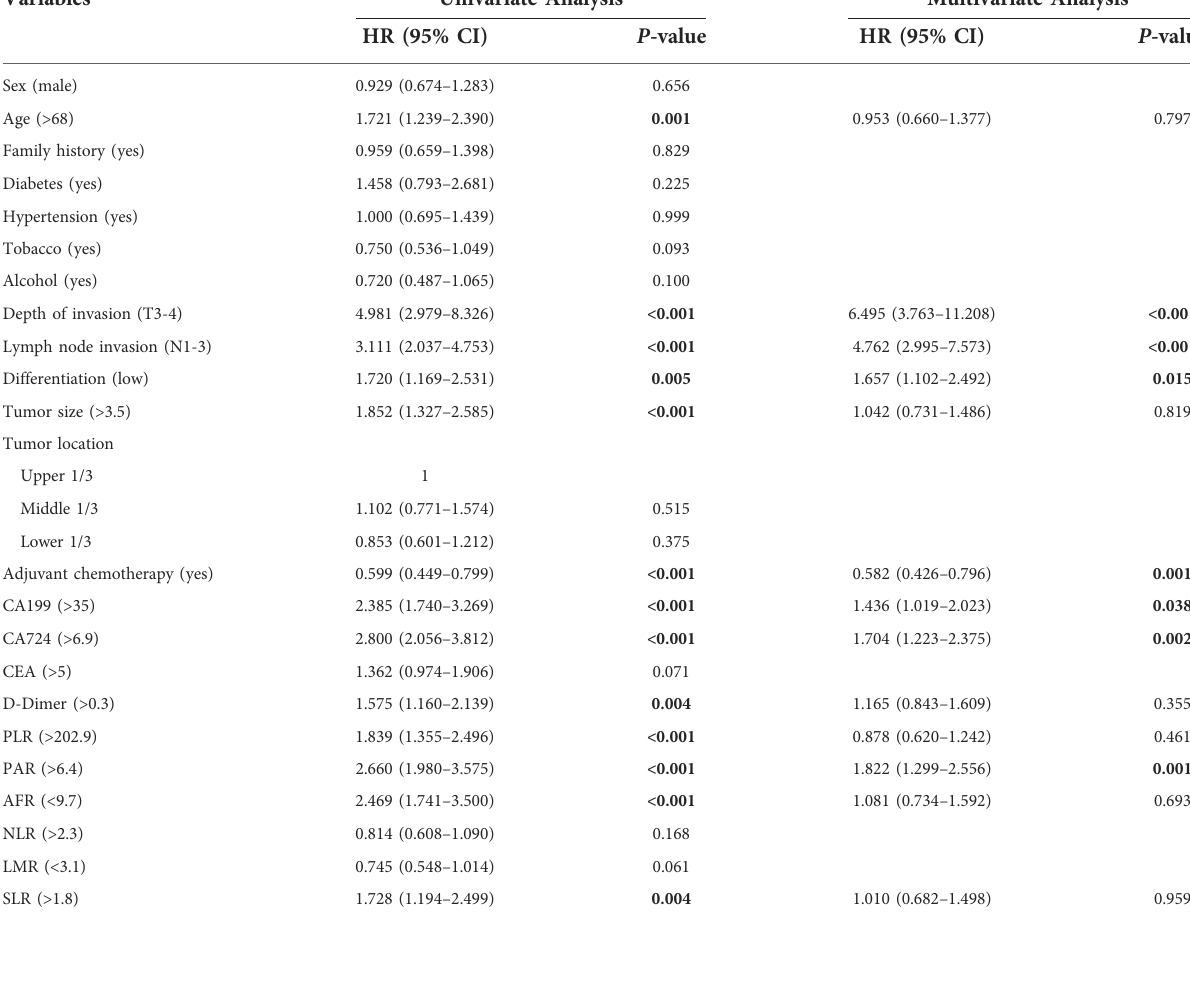
TABLE 2 Univariate and multivariate cox regression analyses of prognostic factors for cancer-speci fi c survival.